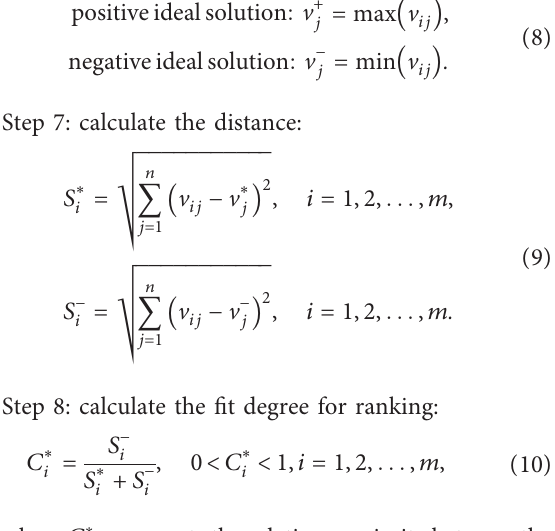
Figure 2: Distribution network of emergency temporary